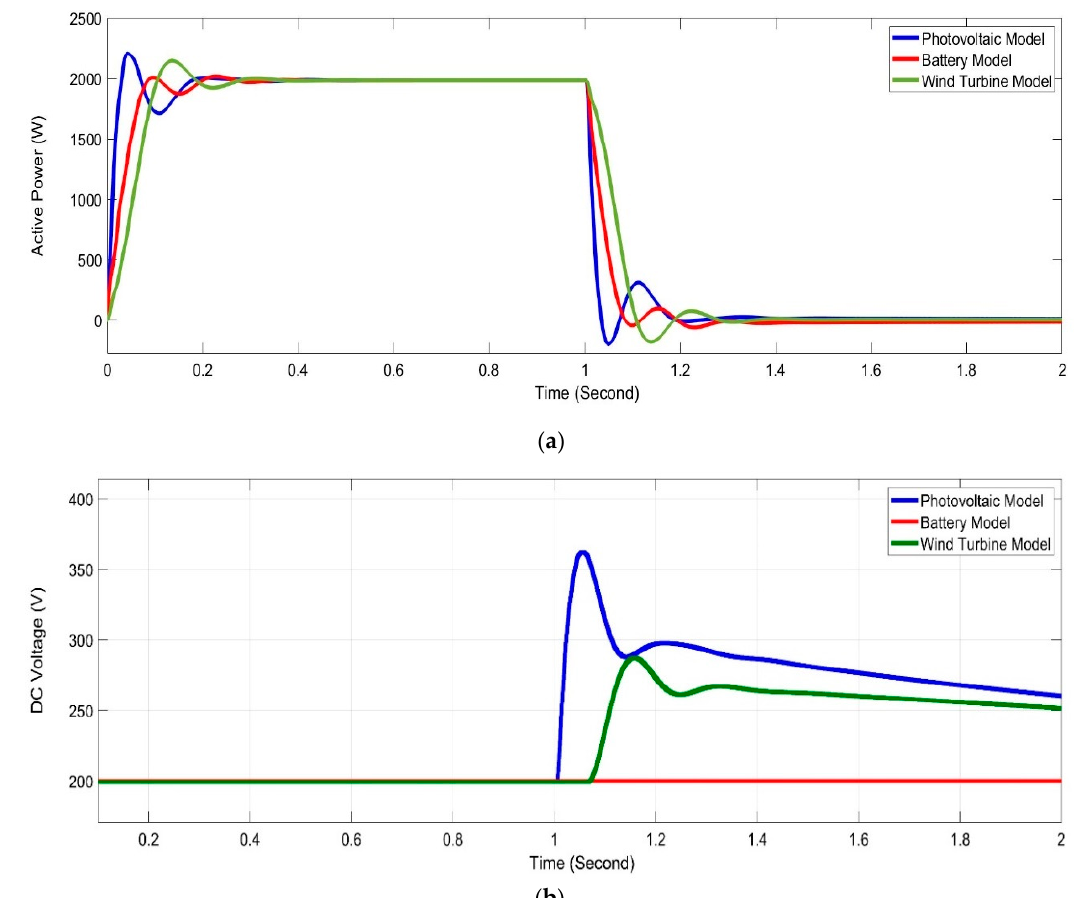
Figure 12. Simulation of identical distribution lines are used, ( a ) inverters power response, ( b ) DC link voltage response under loads change.